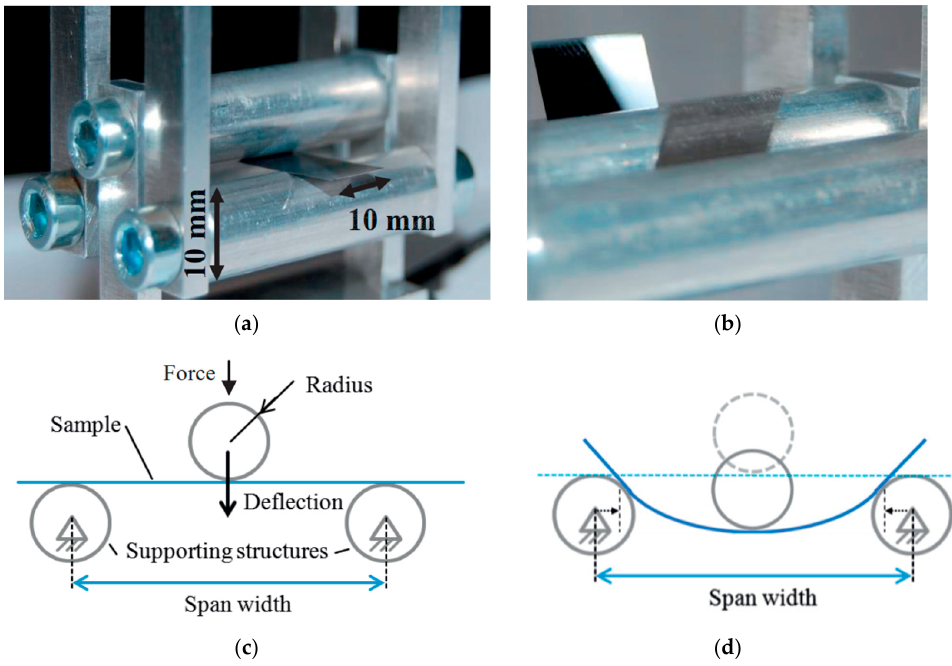
Figure 11. Experimental setup in three-point bending. ( a ) Perspective view; ( b ) when bending with large deflection; ( c ) diagram of the sample in plain position and ( d ) with a deformed position of the sample. Adapted from [78].